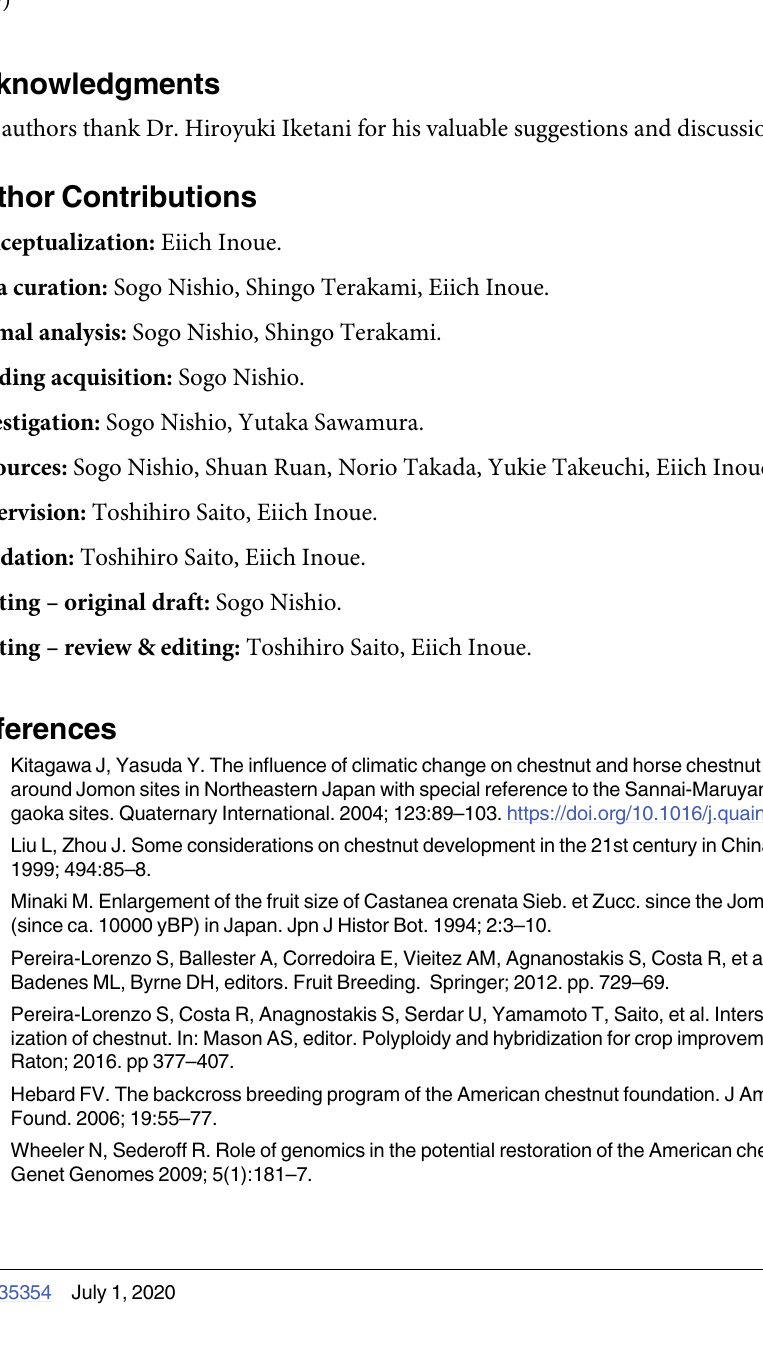
S2 Table. List of the 31 SSR nuclear markers used in the present study. The linkage group (LG) and position (pos) of each marker are based on an integrated map of a Kunimi × 709–34 population (Kx709CP; Nishio et al., 2018). (XLSX) S3 Table Nut harvesting day and nut weight of the cultivars preserved at the NARO Gene- bank. (XLSX) S1 Fig. Principal coordinate analysis (PCoA) plot generated from genetic distance calcula- tions among the 116 Chinese chestnut cultivars in GenAlEx software. Cultivars were classi- fied as predominantly part of the “red” cluster (ratio of “red” > 0.8), the “light green” cluster (ratio of “light green” > 0.8), or admixed (0.8 > ratio of “red” > 0.2; shown here in black).